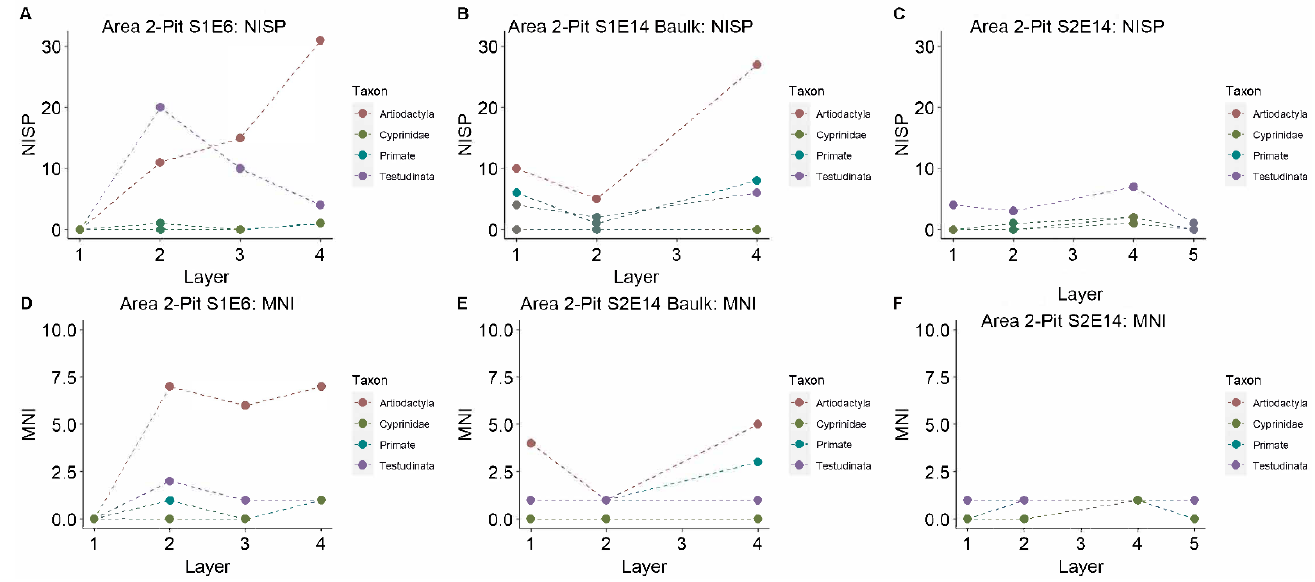
Figure 6. Diachronic change in taxonomic abundance (NISP, number of identified specimens and MNI, minimum number of individuals) within Area 1: ( A , C ) S1E4; and ( B , D ) S2E12.